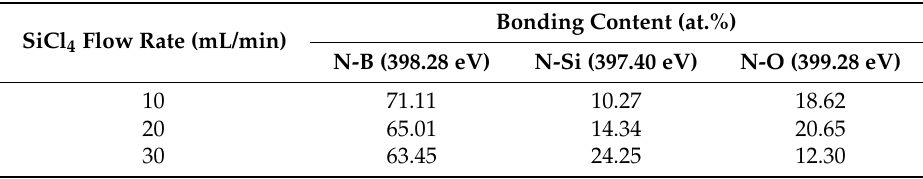
Table 3. Bonding states of N1s and bonding content of SiBN coatings deposited at various SiCl 4 flow